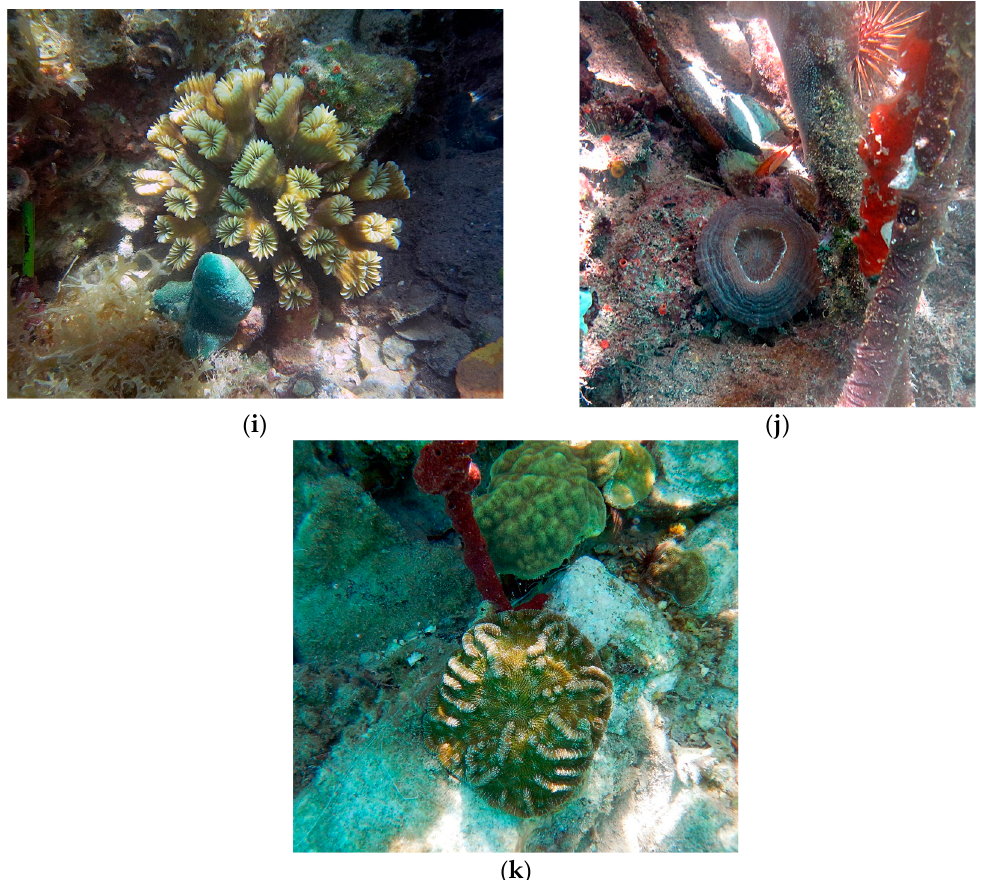
Figure 3. Stony corals in the mangrove-lined bays of Hurricane Hole. ( a ) a colony of Orbicella annularis ; ( b ) a colony of Orbicella faveolata with a small Orbicella sp. recruit visible on the rock just in front of it; ( c ) Colpophyllia natans (foreground) and Orbicella faveolata ; ( d ) Siderastrea siderea ; ( e ) Undaria agaricites and Millepora alcicornis ; ( f ) Poritesfurcata ; ( g ) Porites astreoides ; ( h ) Diploria labyrinthiformis and Orbicella annularis surrounded by Porites porites ; ( i ) Eusmilia fastigiata ; ( j ) Scolymia sp.; ( k ) Mycetophyllia aliciae with Porites astreoides in the background .